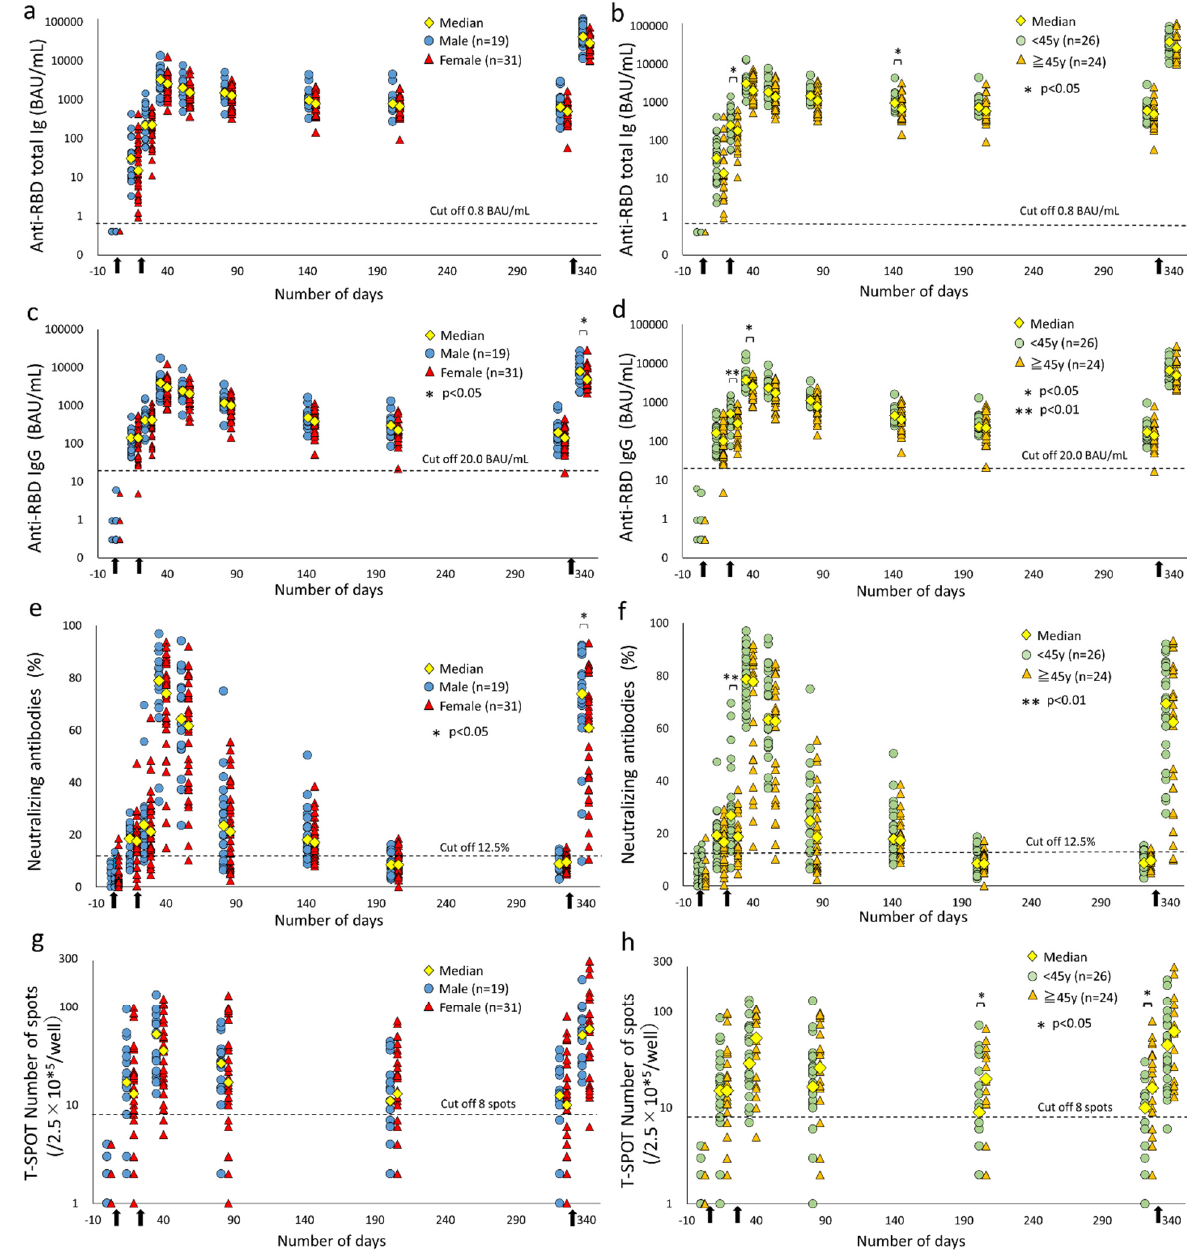
Figure 1. ( a – h ). A one-year dynamics of humoral and cell-mediated immunity against SARS-CoV- 2 with three doses of the BNT162b2 vaccine. The levels of anti-RBD total Ig ( a , b ) and IgG ( c , d ), neutralizing antibodies ( e , f ), and T-SPOT ( g , h ) against SARS-CoV-2 are plotted in a time series after vaccine dose by gender and age. Blue and red plots represent the results by gender. Green and orange plots represent the results by age in two groups over or under 45 years old. The yellow plots represent the median of each time point in the group. The dashed line represents the cutoff value in each immunity parameter. p -values were calculated using the Mann–Whitney U test, and significance was set at 0.05. The arrow (black) indicates the vaccine dose date (the first, second, and booster doses were injected in March 2021, April 2021, and January 2022, respectively). Y-axis: ( a , b ), anti-RBD total Ig (Elecsys ® anti-SARS-CoV-2 S; Roche); ( c , d ), anti-RBD IgG (HISCL TM SARS-CoV-2 S-IgG; Sysmex); ( e , f ), neutralizing antibodies (SARS-CoV-2 Neutralization Antibody Detection Kit; MBL); ( g , h ), T-SPOT (T-SPOT ® Discovery SARS-CoV-2; Oxford Immunotec). The anti-RBD antibodies and T-SPOT are shown on a log scale.